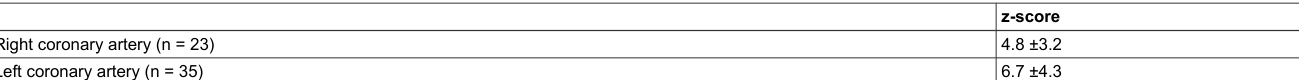
Right coronary artery (n = 23)